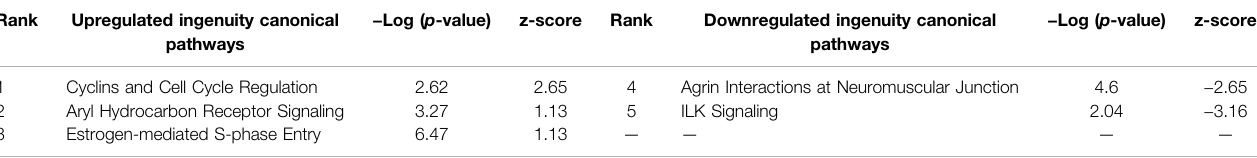
TABLE2| IngenuityPathwayAnalysistableofCanonicalPathwaysfromCDxCIDEGs( p < 0.01,logfoldchange > 1/ < -1).Redundantpathways,pathwayswithnoz-scoreor z-score between -1 and one removed. Mapped IDs: 9865; unmapped IDs: 4922.459 analysis-ready molecules: 245 upregulated and 214 downregulated. Left: upregulated pathways. Right: Downregulated pathways. Ranked by z-score. Rank Upregulated ingenuity canonical pathways Cyclins and Cell Cycle